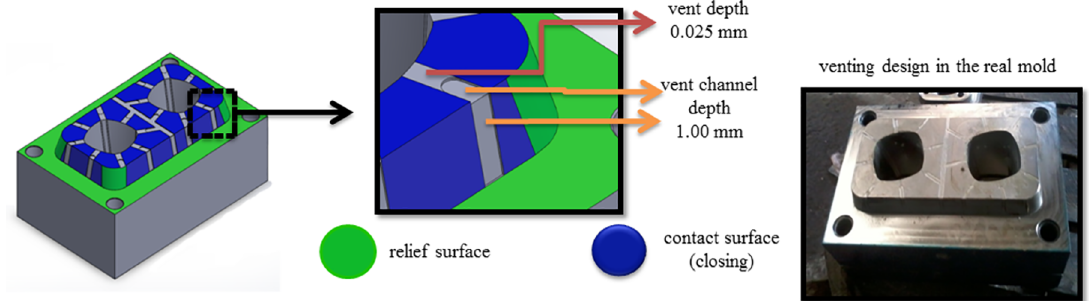
Figure 3. Mechanical modifications in the inferior cavity of the mold: air vents in the virtual project and real mold.